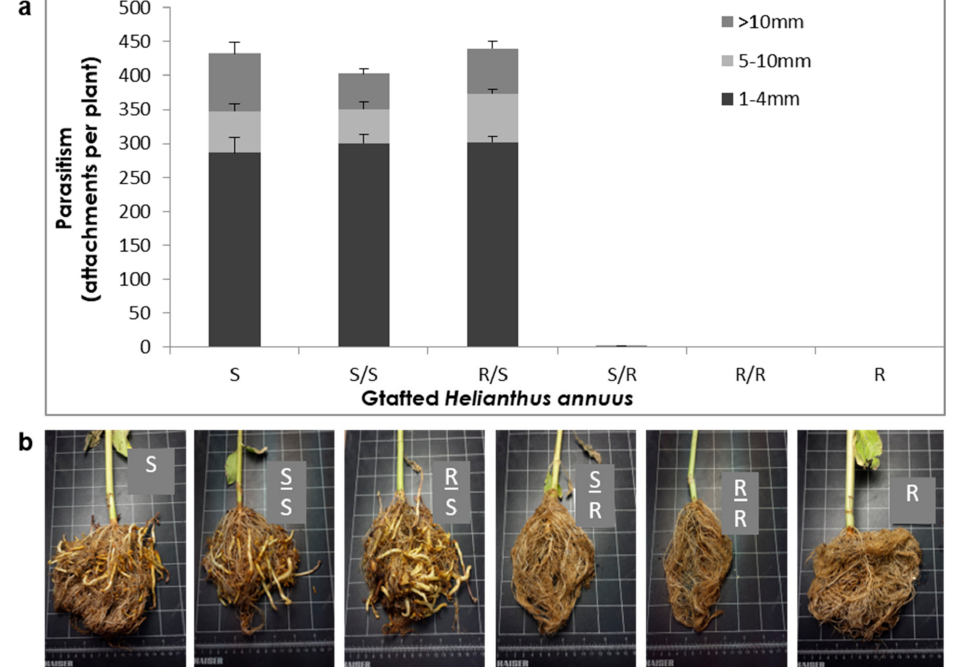
Figure 1. ( a ) Number of O. cumana tubercles parasitizing grafted sunflower plants (+SE). S: non- grafted susceptible sunflower; S/S: self-grafted susceptible sunflower; R/S: resistant sunflower shoot grafted onto susceptible sunflower rootstock; S/R: susceptible sunflower shoot grafted onto resistant sunflower rootstock; R/R: self-grafted resistant sunflower; R: non-grafted resistant sunflower. ( b ) Grafted and non-grafted sunflower roots 52 d post-infestation with O. cumana